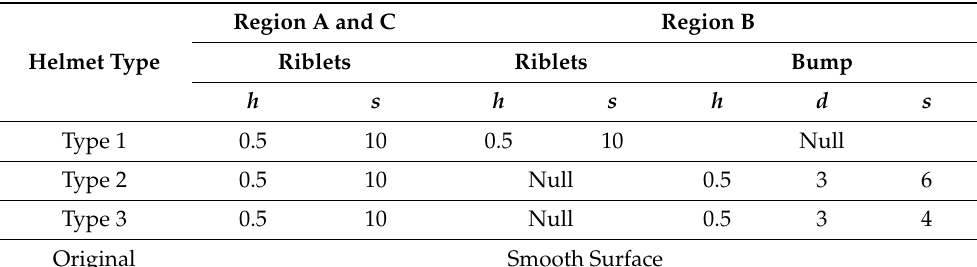
Figure 7. ( a ) the position to print surface structure on helmet; the surface structure parameters of bumps ( b ) and riblets ( c ). Table 2. Parameters of surface structure used in four types of helmets tested in wind tunnel exper- iments (unit: mm).